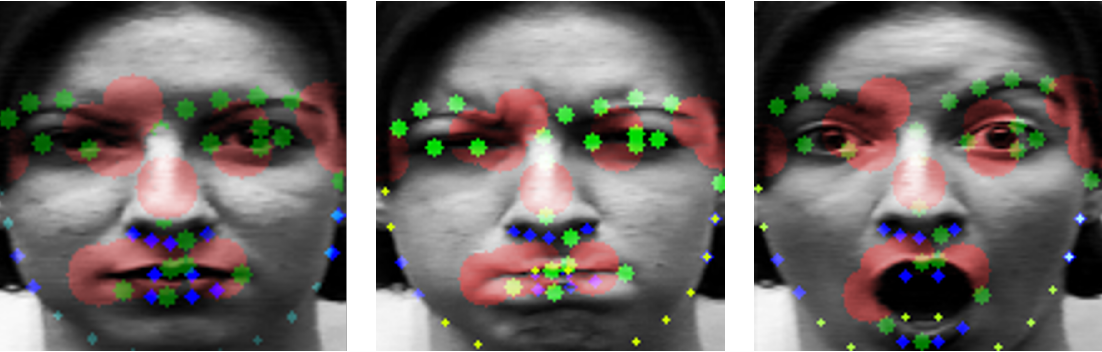
Figure 7. Movement distribution of landmarks.